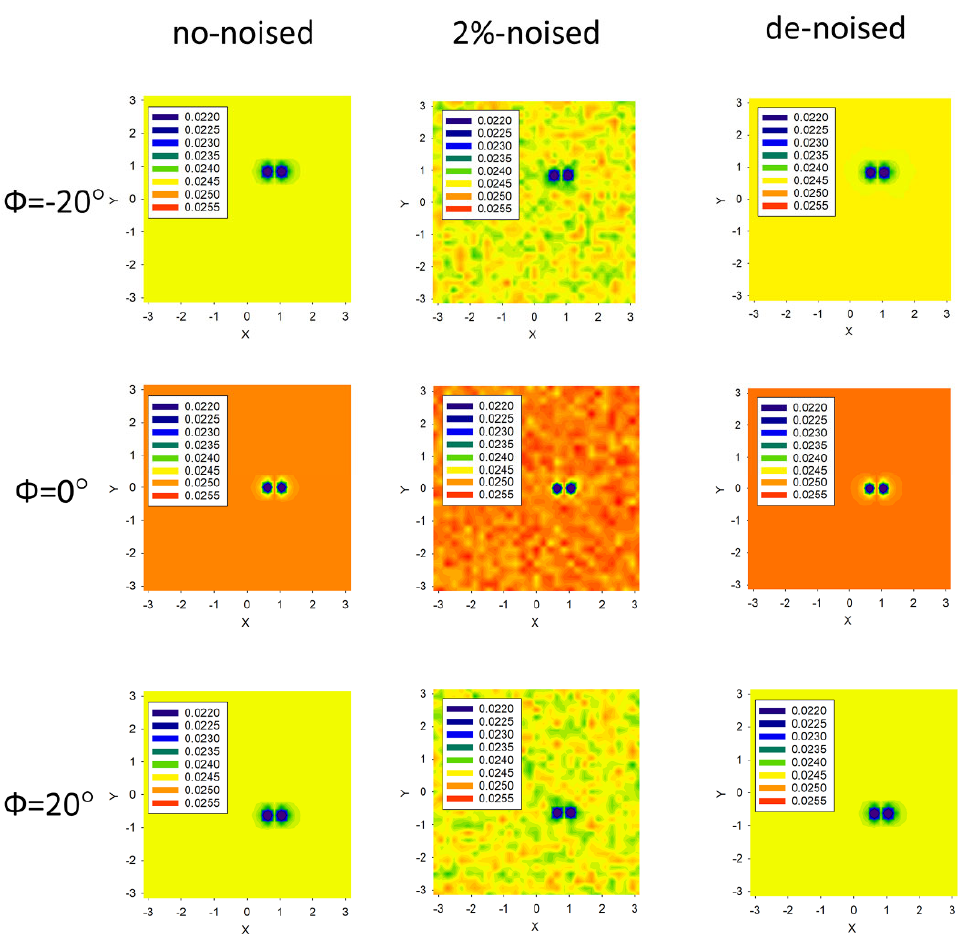
Figure 2. The 2D IPs: no-noise (left), 2%-noise level (middle) and de-noised (right). The number of non-averaged IPs data frames is equal to 100. The sample rotation angles Φ are equal to { − 20 ◦ , 0 ◦ , 20 ◦ }, respectively.